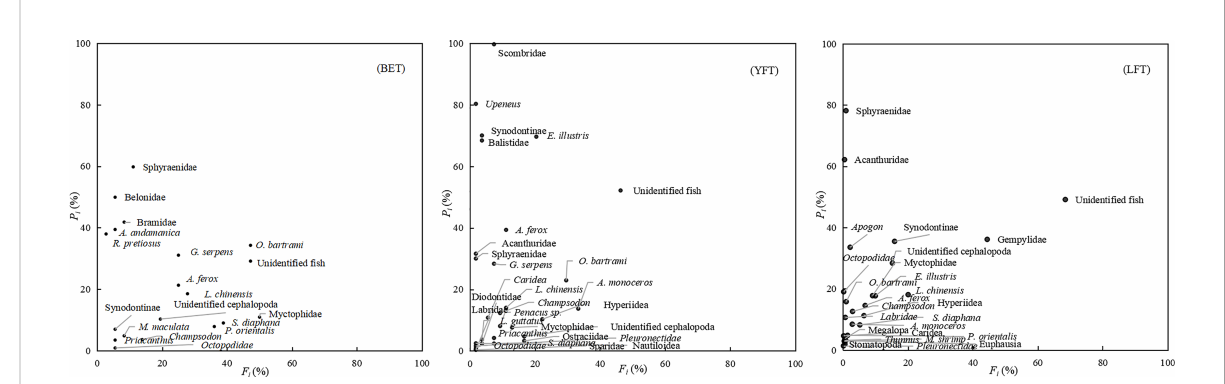
FIGURE 3 Relationship between relative prey-speci fi c abundance (P i , %) and frequency of occurrence (F i , %) of prey items in the diet of three species of tuna. BET, big eye tuna, Thunnus obesus ; YFT, yellow fi n tuna, T. albacares ; LFT, albacore tuna, T. alalunga